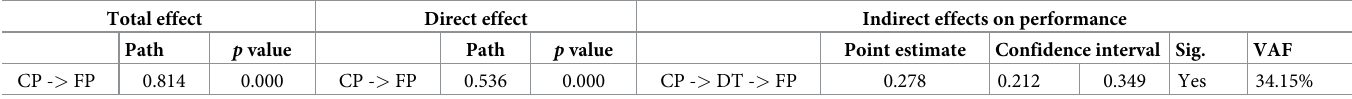
Table 7. The mediating effect